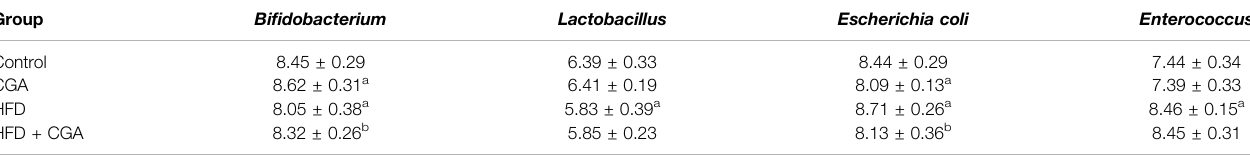
TABLE 2 | Quantitation analysis of gut microbiota in fecal samples by real-time PCR (Mean ± SD). Group